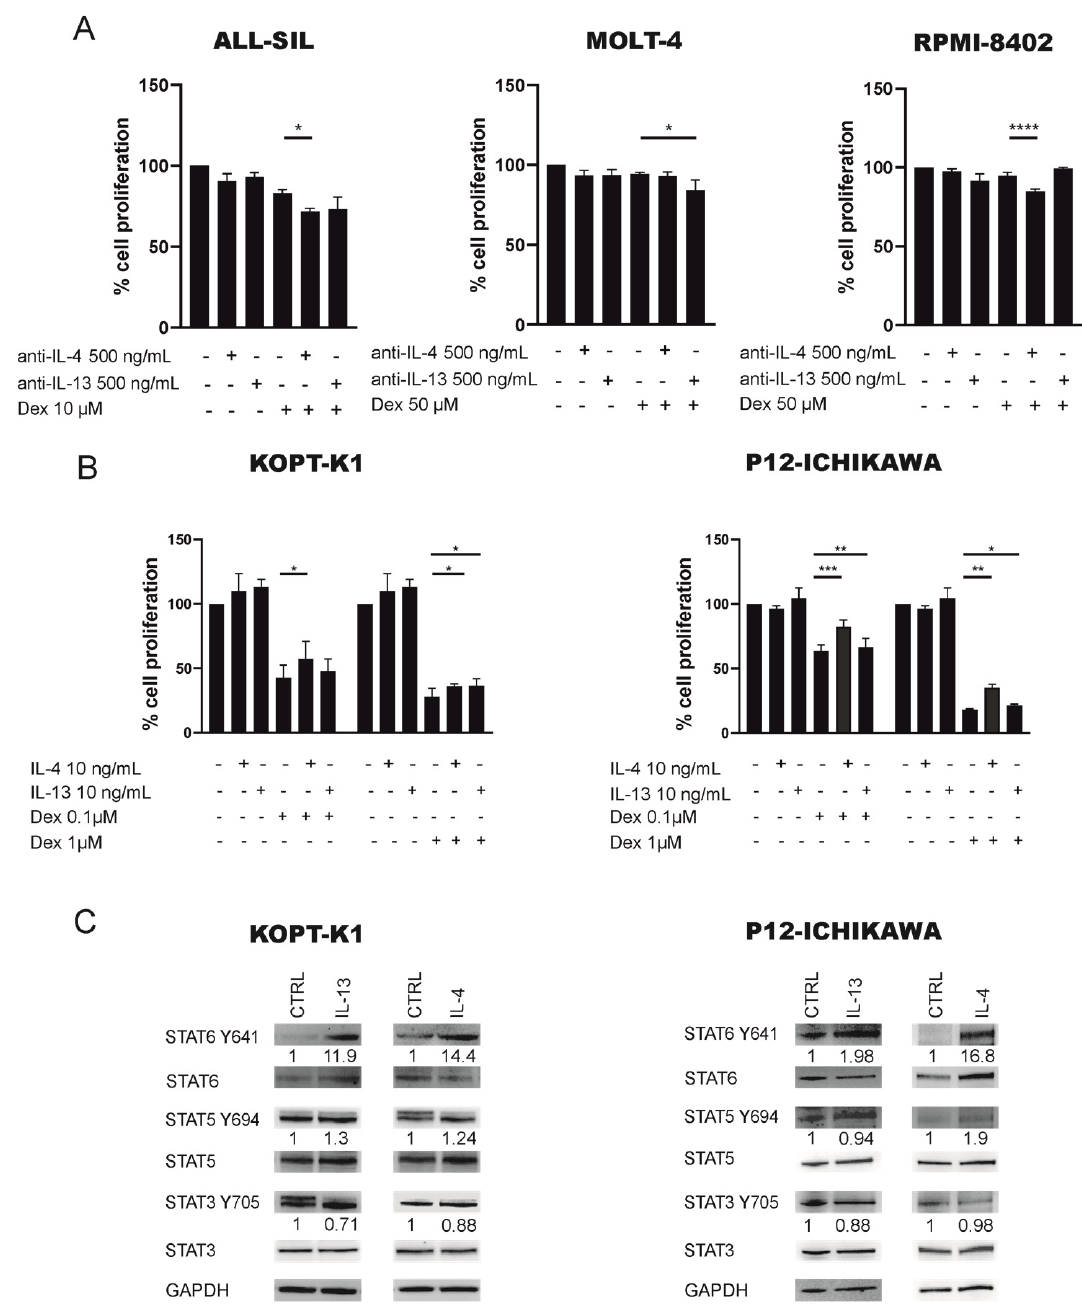
Figure 2. Blockade of IL-4/IL-13 pathway increases the response to dexamethasone by STAT6 activation and GR binding. ( A ) The anti-IL-4 or anti IL-13 neutralizing antibody increases GC-induced cell death in GC resistant cell lines ALL-SIL, MOLT-4 and RPMI-8402. Cells were treated with 500 ng/mL of blocking antibody for 16 h prior to dexamethasone treatment (10 µ M for ALL-SIL, 50 µ M for MOLT-4 and RPMI-8402 for 48 h), and cell proliferation was evaluated by MTT assay, at least in triplicate. Cell proliferation of control DMSO treated cells was set to 100%. Results are presented as means ± SEM. ( B ) Cell proliferation measured by MTT assay of KOPT-K1 and P12-ICHIKAWA cells treated or not (CTRL) for 16 h with IL-4 or IL-13 (10 ng/mL) followed by dexamethasone (1–0.1 µ M) for 48 h ( n = 3). Cell proliferation of control DMSO treated cells was set to 100%. Results are presented as means ± SEM ( n = 3) (* p < 0.05; ** p < 0.01; *** p < 0.001; **** p < 0.0001. paired t test). ( C ) WB analysis of STAT6 Y641 increase phosphorylation level after IL-4 or IL-13 (10 ng/mL) stimulation of KOPT-K1 and P12-ICHIKAWA cell lines. Of note, STAT5 Y694 and STAT3 Y705 phosphorylation is not increased as well as the respective total form. Intensity values of every protein are normalized on GAPDH first. Following the values of phosphorylated STATs are normalized on the respective total form.